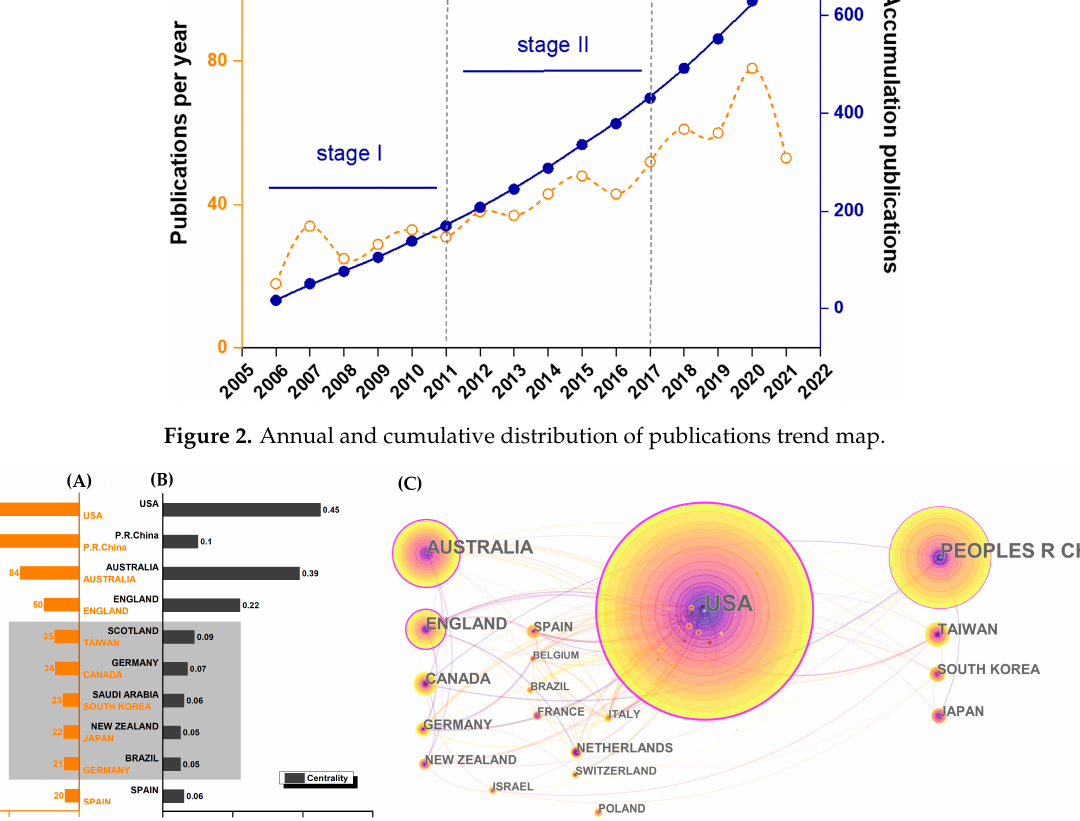
Figure 2. Annual and cumulative distribution of publications trend map.